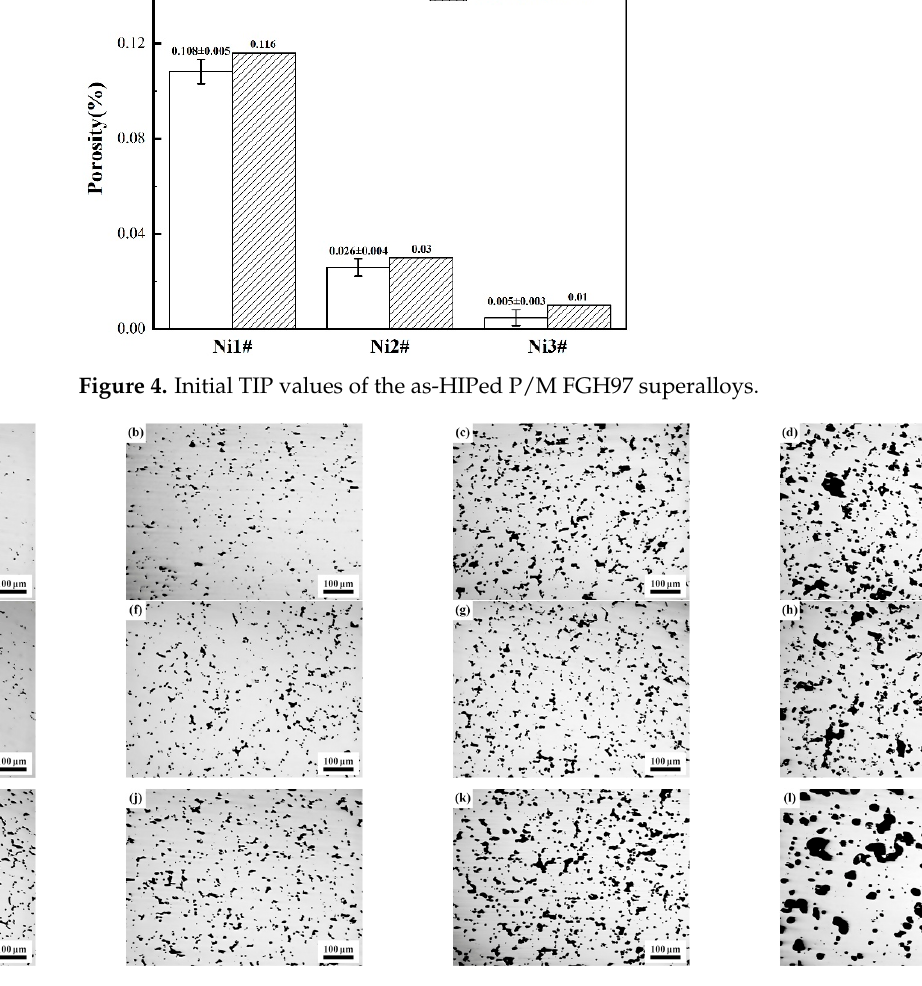
Figure 6. OM images of the Ni2# superalloy after solution heat treatment, ( a ) 1150 °C × 0.5 h, ( b ) 1150 °C × 2 h, ( c ) 1150 °C × 4 h, ( d ) 1175 °C × 0.5 h, ( e ) 1175 °C × 2 h, ( f ) 1175 °C × 4 h, ( g ) 1200 °C × 0.5 h, ( h ) 1200 °C × 2 h, and ( i ) 1200 °C × 4 h. Figure 7. OM images of the Ni3# superalloy after solution heat treatment, ( a ) 1150 °C × 0.5 h, ( b ) 1150 °C × 2 h, ( c ) 1150 °C × 4 h, ( d ) 1150 °C × 8 h, ( e ) 1175 °C × 0.5 h, ( f ) 1175 °C × 2 h, ( g ) 1175 °C × 4 h, ( h ) 1175 °C × 8 h, ( i ) 1200 °C × 0.5 h, ( j ) 1200 °C × 2 h, ( k ) 1200 °C × 4 h, and ( l ) 1200 °C × 8 h.